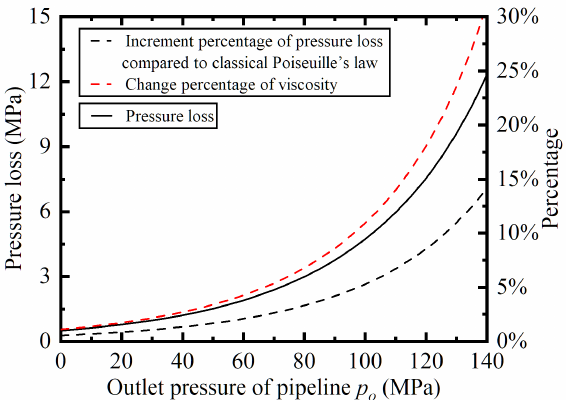
Figure 14. Pressure loss versus outlet pressure of pipeline.